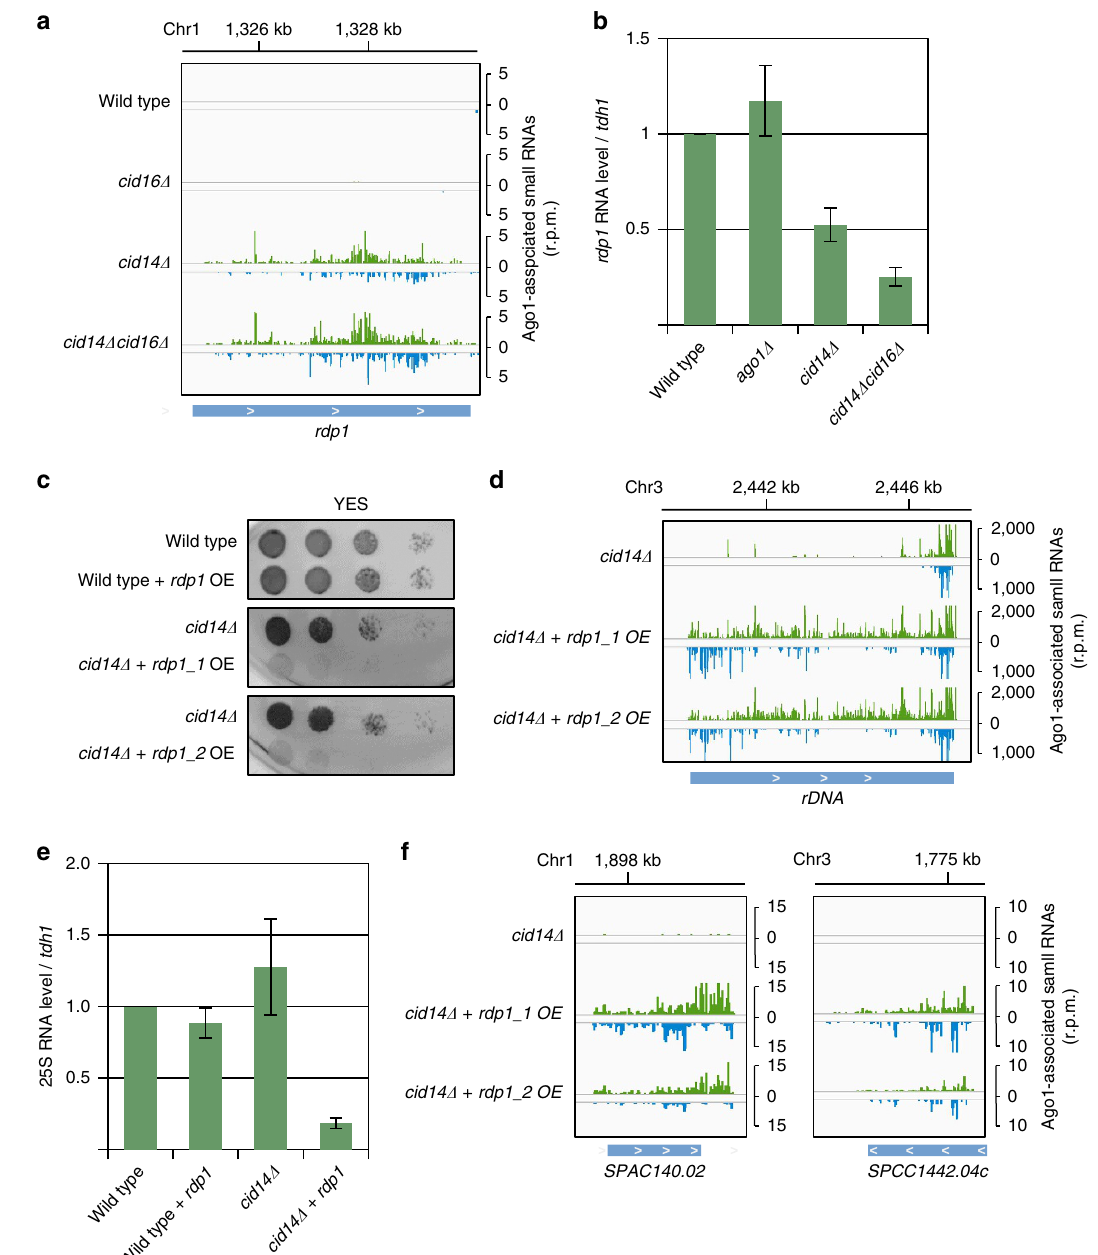
Figure 4 | RNAi silences rdp1 to reduce uncontrolled RNAi in cid14 D cells. ( a ) Argonaute-bound sRNA reads from indicated strains were plotted over rdp1 gene. The location of genes is indicated below the sRNA peaks. Reads from þ and (cid:2) strands are depicted in green and blue, respectively. Scale bars on the right denote sRNA reads numbers normalized per one million reads. In cid14 D and cid14 D cid16 D cells, RNAi targets rdp1 . ( b ) Quantification of rdp1 transcripts in indicated strains by RT-qPCR. In cid14 D and cid14 D cid16 D cells rdp1 mRNA is strongly reduced. Error bars indicate s.e.m. of three independent experiments. ( c ) Growth assay showing strong reduction in viability of cid14 D cells that over-express rdp1 gene. Cells were growing for 2 days before imaging. ( d ) Argonaute-bound sRNA reads from indicated strains were plotted over rDNA. Reads from þ and (cid:2) strands are depicted in green and blue, respectively. Scale bars on the right denote sRNA read numbers normalized per one million reads. In cid14 D cell over-expressing Rdp1, much higher amount of siRNAs are generated at rDNA. ( e ) Quantification of 25S rRNA transcript in indicated strains by RT-qPCR. In cid14 D cells that over-express rdp1 gene, 25S rRNA is 5-fold reduced. Error bars indicate s.e.m. of three independent experiments. ( f ) Argonaute-bound sRNA reads from indicated strains were plotted over indicated genes. Reads from þ and (cid:2) strands are depicted in green and blue, respectively. Scale bars on the right denote sRNA reads numbers normalized per one million reads. In cid14 D cells over-expressing Rdp1, RNAi targets new protein coding